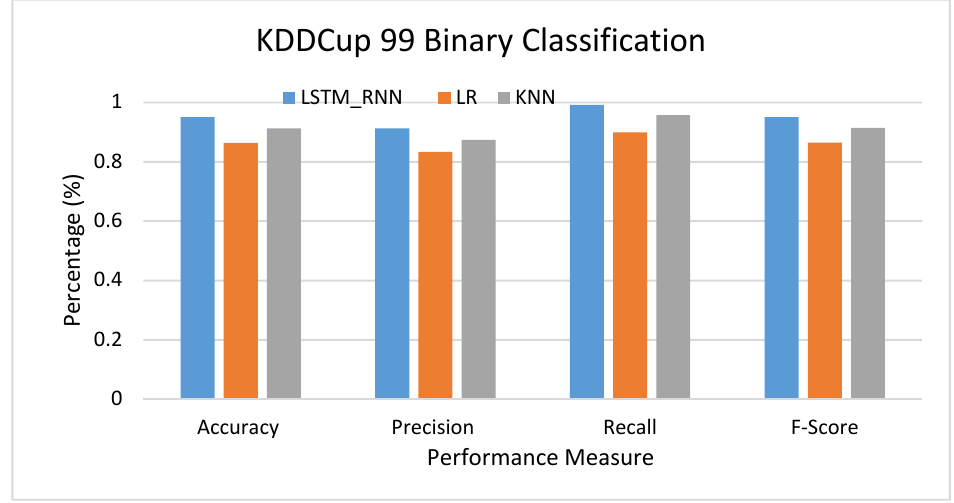
Figure 15. KDDCup 99 Binary classification performance comparison.